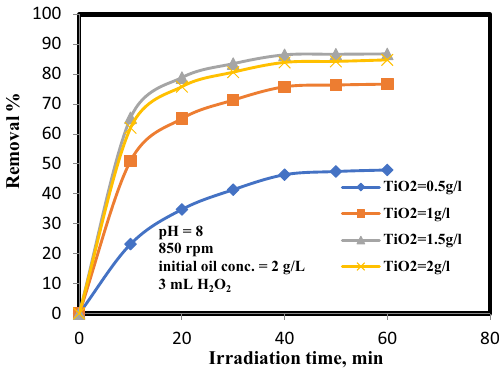
Figure 5. Influence of ttitanium dioxide (TiO 2 ) concentrations on oil